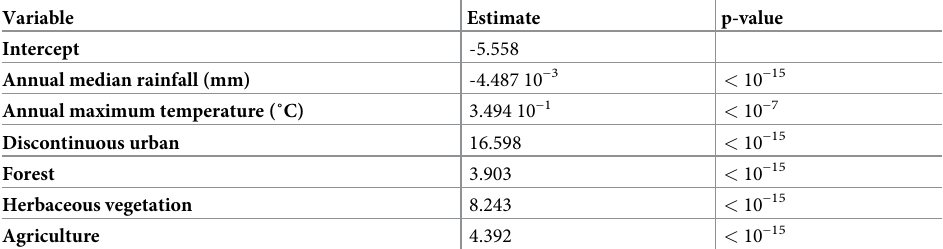
Table 2. Multivariate model explaining Xenopsylla Genus Flea Index from climatic and environmental